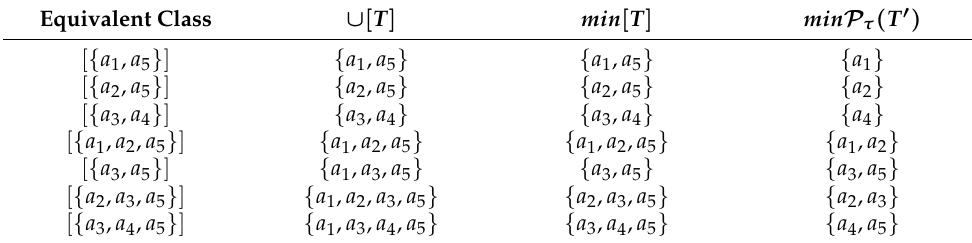
Table 5. Closed itemset and minimal generators of each equivalent